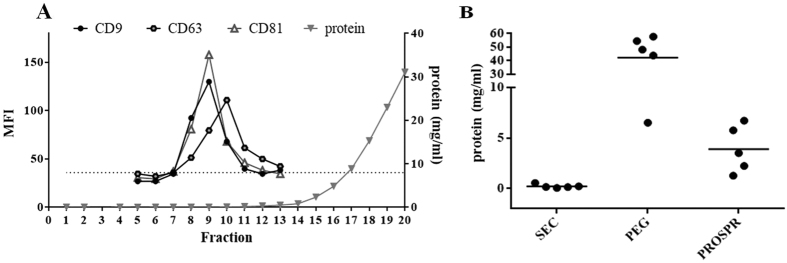
Protein content of EVs is dependent of the isolation method.(A) Representative experiment of plasma-derived EVs eluted in low protein fractions after SEC isolation. A total of 20 fractions of 0.5 mL were collected and the presence of tetraspanins CD9, CD63, CD81 and total protein content were determined. The three top MFI tetraspanin fractions of each experiment were pooled for further analyses. A representative sample of five independent experiments is shown. The isotype negative control is represented as a dashed line. (B) Protein concentration from different EV-enriched preparations measured by absorbance at 280 nm and calculated using a BSA standard curve. Protein content from SEC-EVs was determined in the pooled fractions. Five independent experiments are shown.